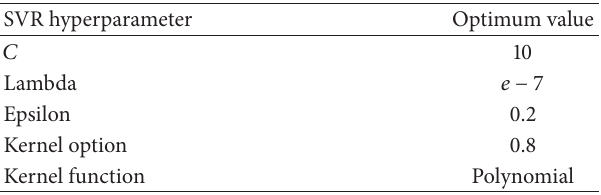
Table 2: Statistical analysis of the dataset used in modeling STTE. Table 3: Optimum parameters for the developed model (STTE).